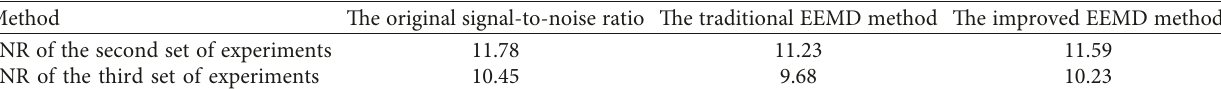
Table 2: The other two sets of denoising effects comparison.